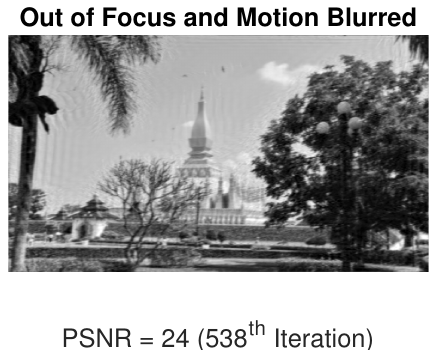
Figure 40. The reconstructed grey image of all cases using the proposed method (2) with PSNR = 24.